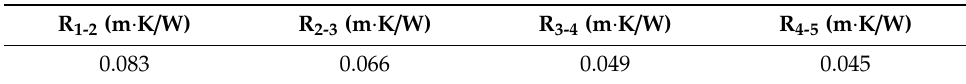
Table 8. Thermal resistances for the material included between sensors S1–S2 (R 1-2 ), S2–S3 (R 2-3 ),